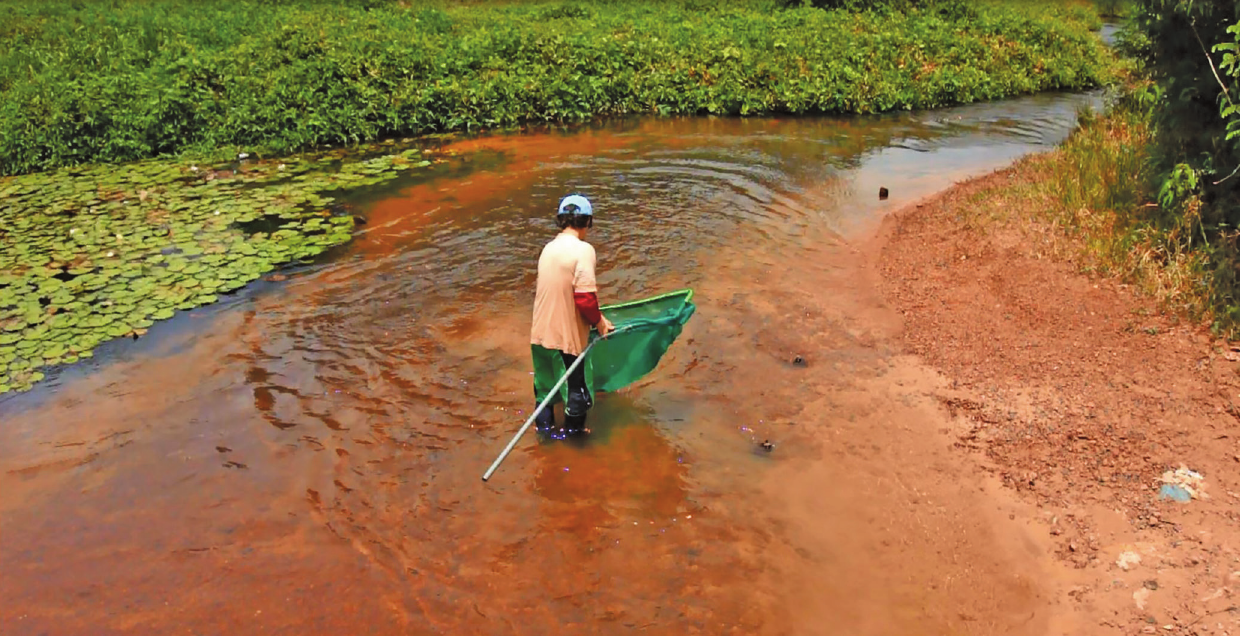
Fig. 5. Type-locality of Curculionichthys hera , igarapé do Onça, tributary to rio Curuá-Una on road BR-163 between Belterra and Rurópolis, Belterra, Pará,